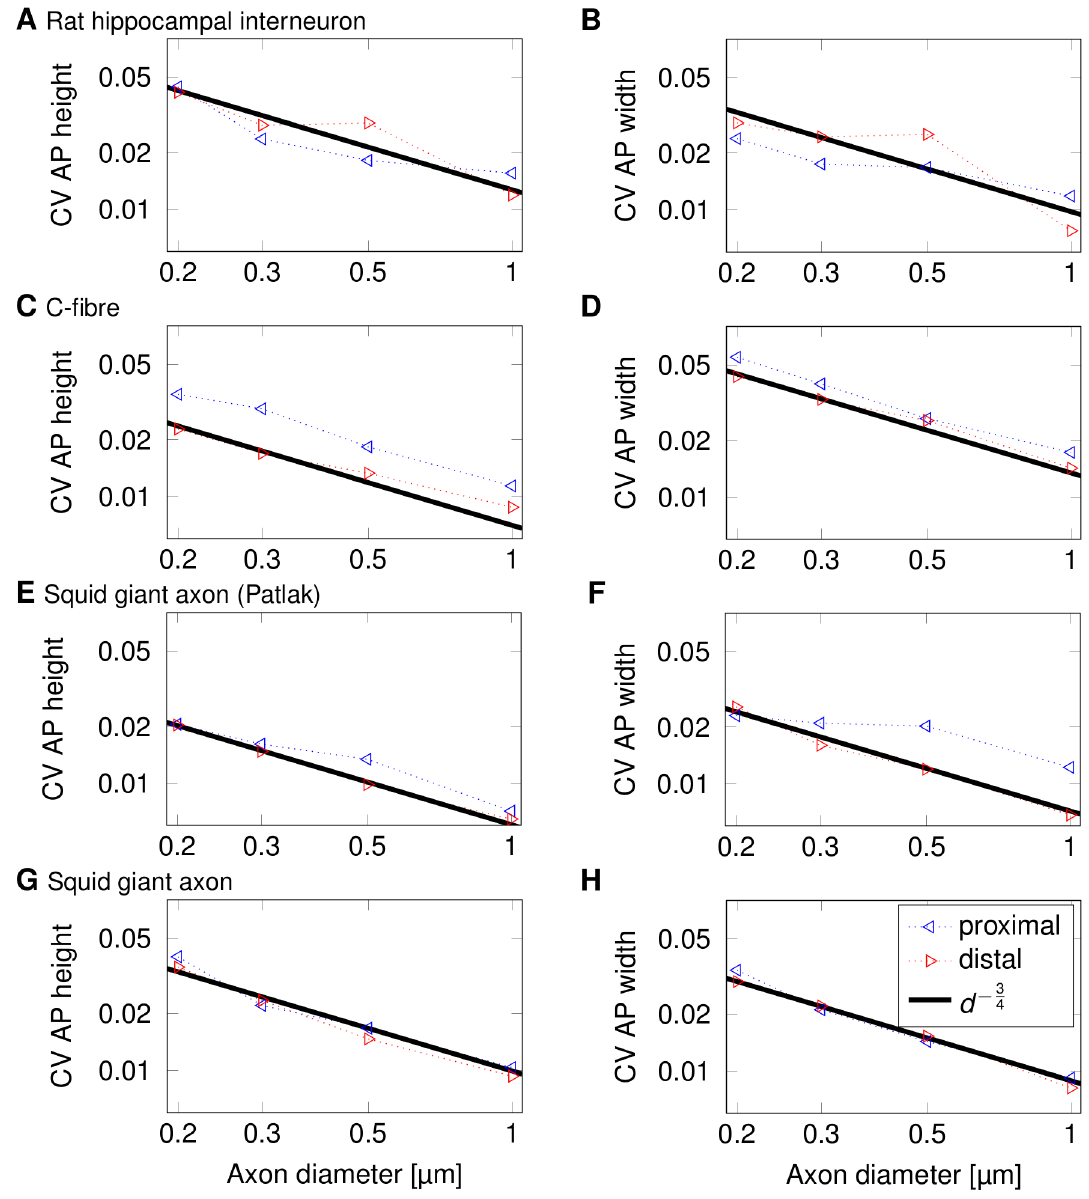
Figure 5. Variability of the AP width and height scales with axon diameter. The power-law relationship is valid at both proximal (left- pointed triangle) and distal (right-pointed triangle) points in all four types of axons. (A) Log-log plot of CV of AP height over diameter for a rat hippocampal interneuron. (B) Log-log plot of CV of AP width over diameter for a rat hippocampal interneuron. (C) Log-log plot of CV of AP height over diameter for a c-fibre axon. (D) Log-log plot of CV of AP width over diameter for a c-fibre axon. (E) Log-log plot of CV of AP height over diameter for a squid giant axon with Patlak channels. (F) Log-log plot of CV of AP width over diameter for a squid giant axon with Patlak channels. (G) Log-log plot of CV of AP height over diameter for a squid giant axon. (H) Log-log plot of CV of AP width over diameter for a squid giant axon.